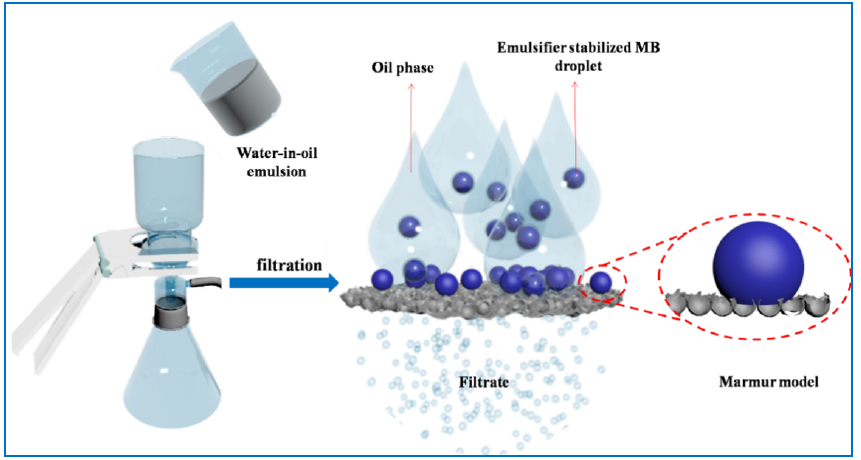
Scheme 2. Possible separation mechanism of water-in-oil emulsions on the HSMX-based mem-brane.